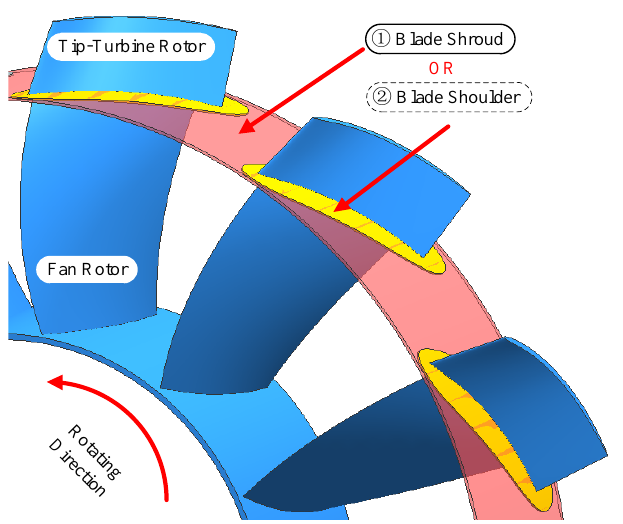
Figure 1. 3D Model of the ADFTT rotor.